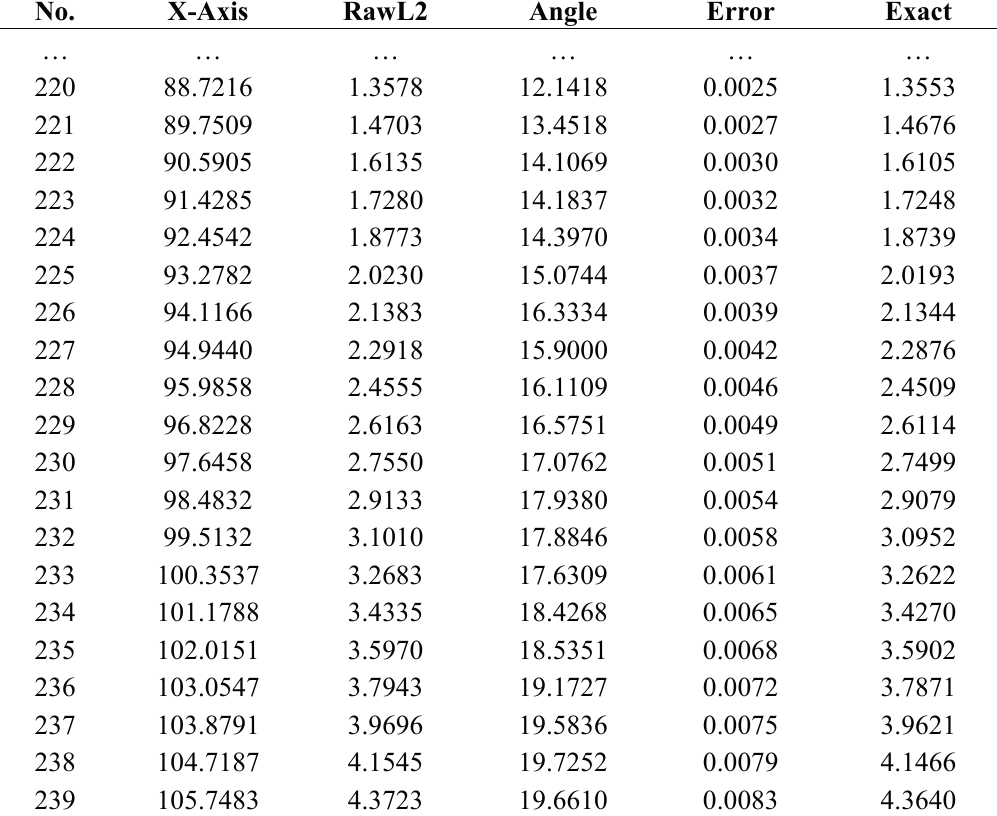
Table 3. Part of the measuring data compensation list